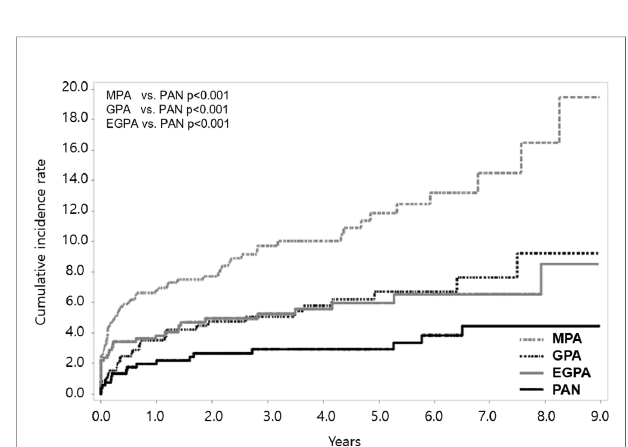
FIGURE 3 | Cumulative incidence rate of stroke according to SNV subgroups. Among the SNV subgroups, the cumulative incidence rate of stroke was found to be highest in MPA. SNV, systemic necrotizing vasculitis; MPA, microscopic polyangiitis; PAN, polyarteritis nodosa; GPA, granulomatosis with polyangiitis; EGPA, eosinophilic granulomatosis with